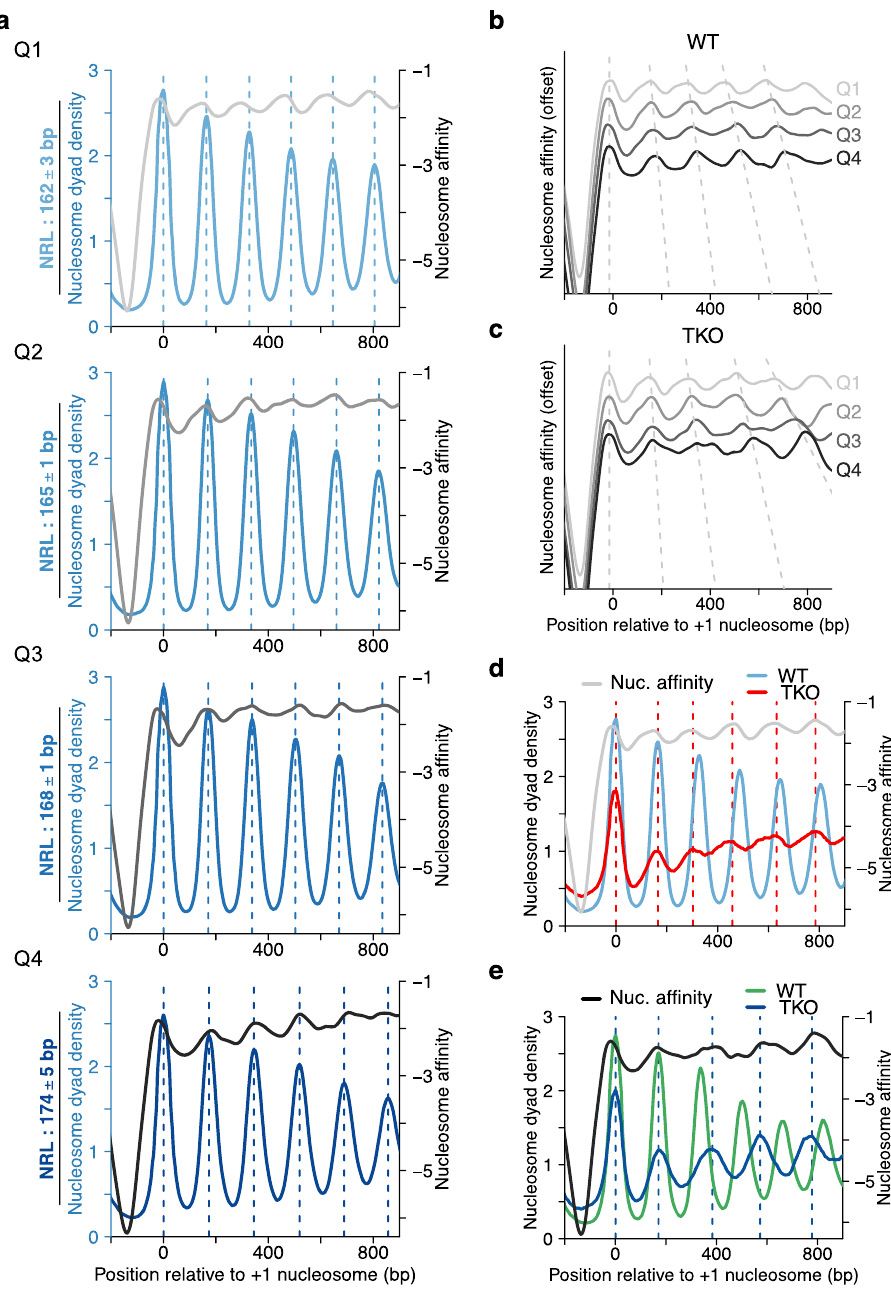
Fig. 6 DNA sequence contributes to NRL determination. a Comparison of gene-averaged MNase-seq data and calculated nucleosome af fi nities for WT cells. Genes were fi ltered (see “ Methods ” section), sorted by NRL and grouped into quartiles from Q1 (shortest) to Q4 (longest NRL). NRL values are mean NRLs and their SD. Nucleosome af fi nities were calculated using nuCpos 48 . b , c Nucleosome af fi nities for Q1 – Q4 of WT ( b ; replotted from a or TKO cells ( c ). d Arrays in Q1 of WT cells assume a shorter NRL in TKO cells. This shorter NRL is more similar to the NRL predicted from nucleosome af fi nities. e The NRL of arrays in Q4 of TKO cells is broadly consistent with the NRL predicted from nucleosome af fi nities. The same genes assume a substantially shorter NRL in WT cells, with peaks in the WT MNase-seq data straying further away from the thermodynamically most stable